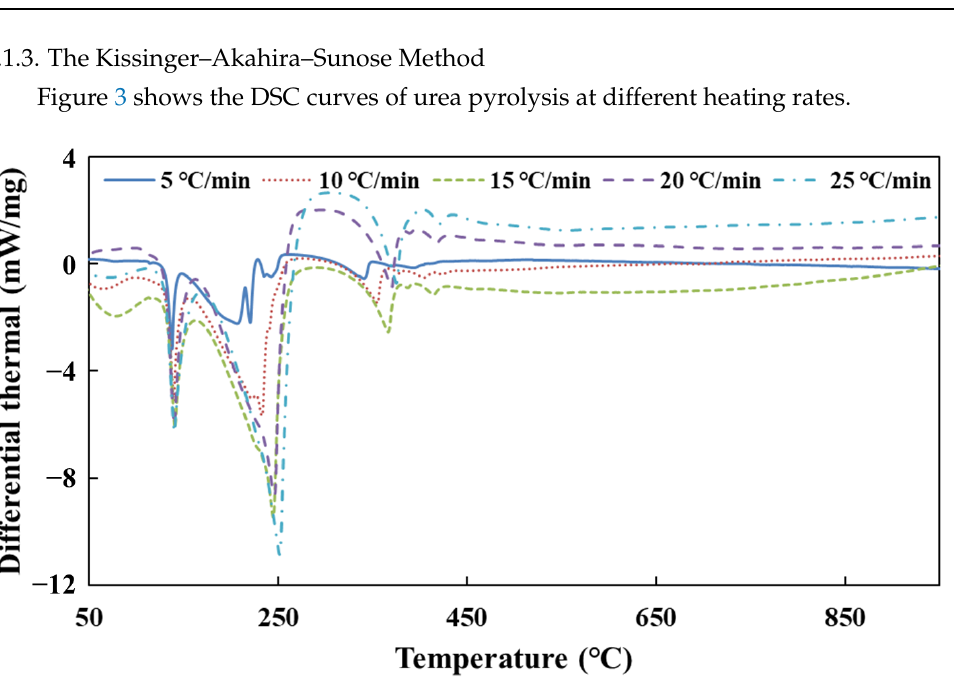
Table 3. The activation energy E F,1 of urea decomposition from one-interval method (Unit: kJ/mol). 1 − α As the results show in Tables 2 and 3, E 34 has a large error in the process of calculating the activation energy of urea decomposition. The reason is that the two thermogravimetric curves of heating rates β 3 and β 4 almost coincide. The difference between temperature T and d α /d T corresponding to them is very small for the same conversion rate α , which brings a large error. Therefore, the set of data was discarded when calculating the total activation energy E . Finally, the activation energy of urea decomposition is 80 kJ/mol (95% confidence interval, CI: 68 – 93, as shown in Figure A2) calculated from the Friedman two- interval method and 84 kJ/mol (95% confidence interval, CI: 66 – 103, as shown in Figure